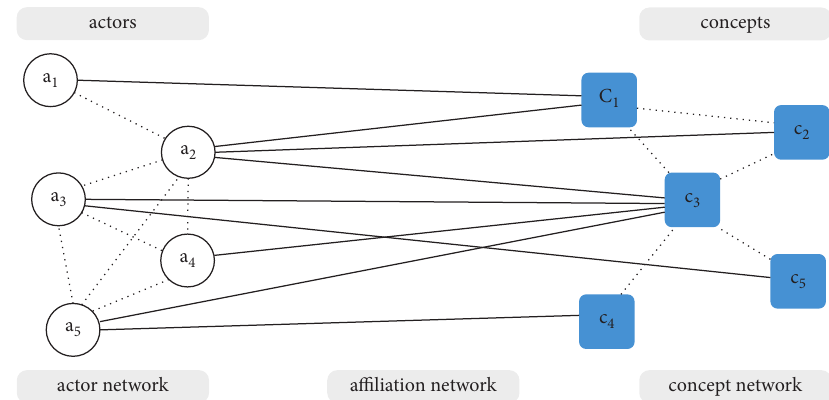
Figure 1: Illustration of the basic model of discourse network.